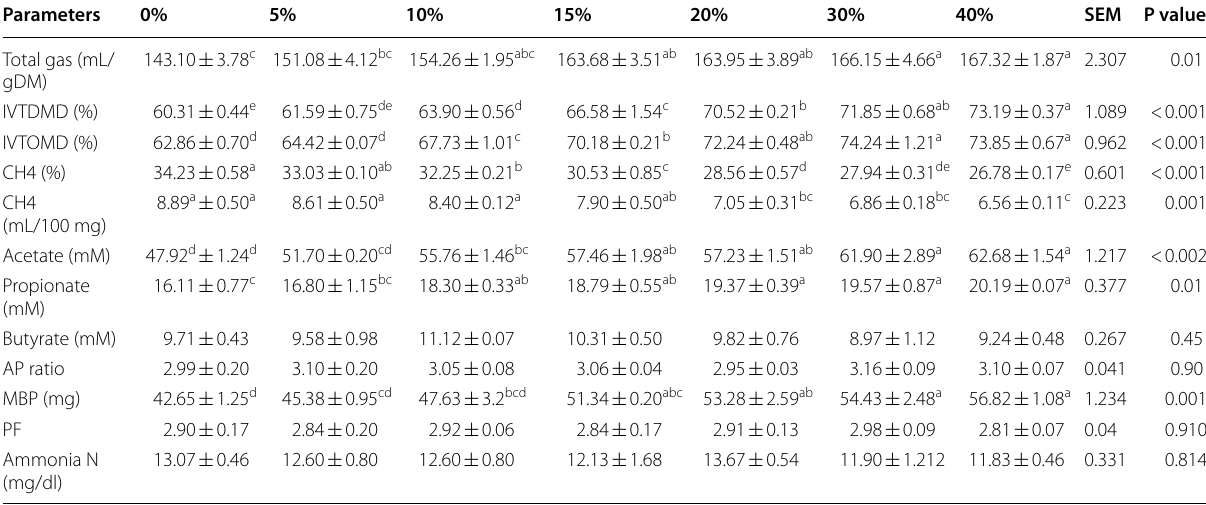
Means with different superscripts a, b, c, d and e in the same row differ significantly ( P <